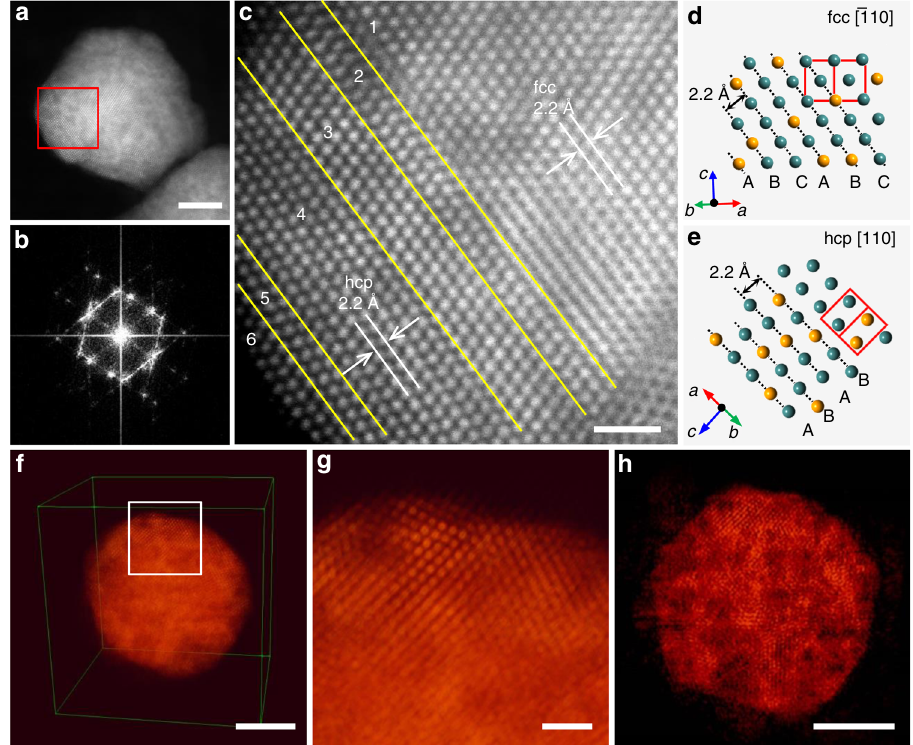
Fig. 3 STEM analysis and crystal models of fcc-AuRu 3 NPs. a Low-magni fi cation HAADF-STEM image of the fcc-AuRu 3 NP. b The corresponding FFT pattern of the NP in ( a ). c The atomic resolution HAADF-STEM image of the red square region in ( a ). d Model for the atomic arrangement of fcc structure viewed along the [110] direction. The unit cell is shown as the red frame. e Model for the atomic arrangement of the hcp structure viewed along the [110] direction. The unit cell is shown as the red frame. f The tomographic reconstruction of the fcc-AuRu 3 NP by EST reconstruction algorithm. g Magni fi ed image of the white square region in ( f ). h The 0.8 Å-thick slice image of the 3D reconstruction near the centre of the NP. The scale bars in ( a ), ( c ), ( f ), ( g ) and ( h ) are 5, 1, 5, 1 and 5